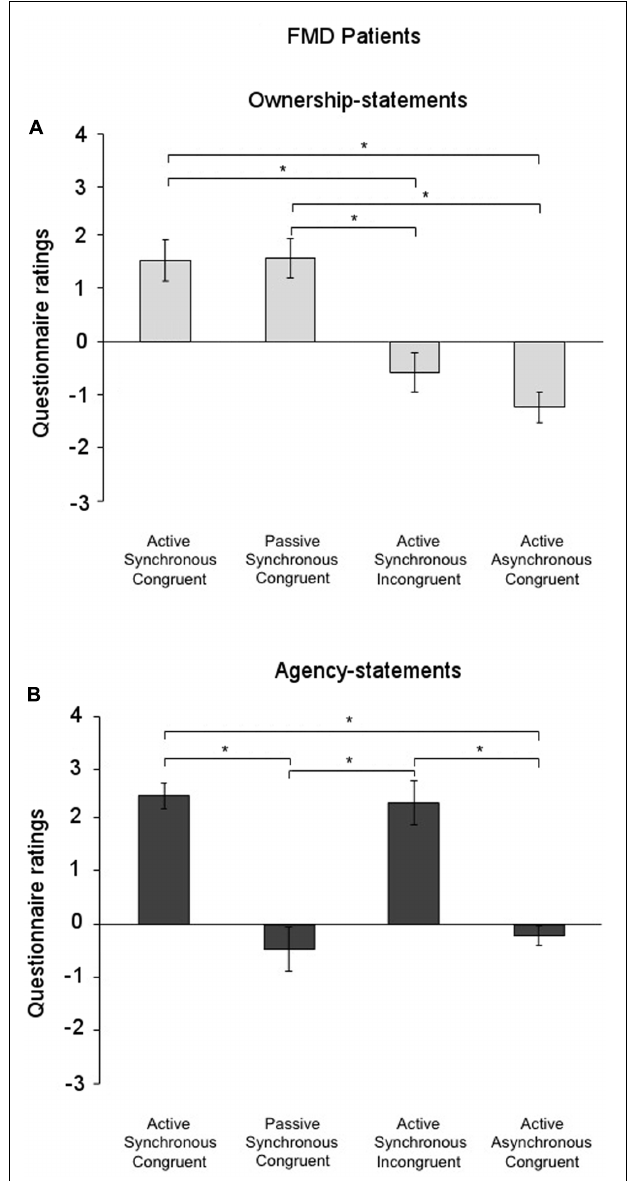
FIGURE 3 | Ownership and agency across conditions in the functional movement disorders group. (A) Mean scores for the ownership-statements and (B) the agency-statements across conditions in the functional movement disorders group. Gray lines and asterisks show significant comparisons across conditions. The results showed that agency and ownership were differently elicited by each condition. Error bars indicate standard errors.